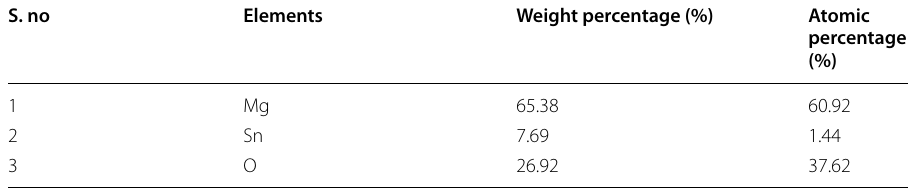
nanocomposite 2